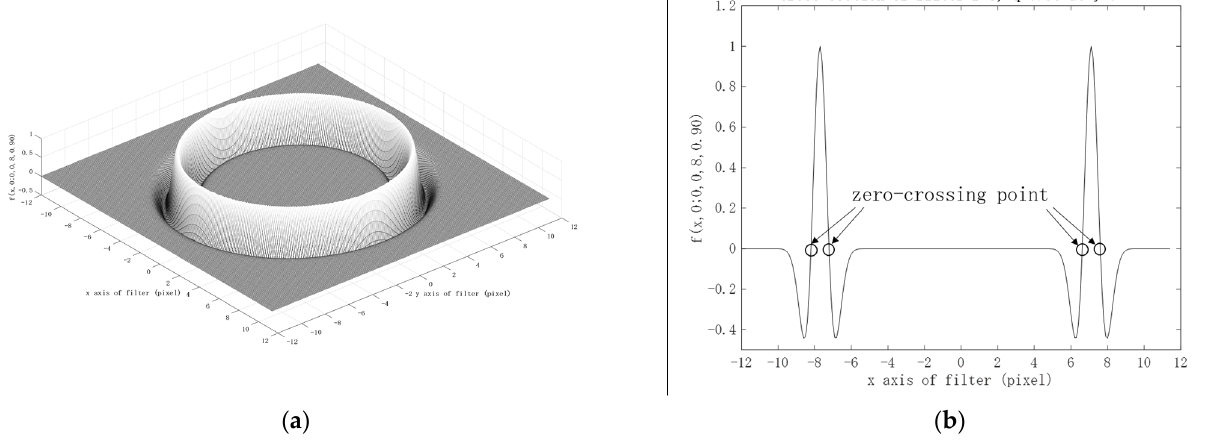
== yx , 8 = r , and 90.0 = q : ( a ) Bird’s-eye view; qryxyxf , with 0 Figure 4. The example of the function ),,,;,( Figure 4. The example of the function f ( x , y ; x 0 , y 0 , r , q ) , with x 0 = y 0 = 0, r = 8, and q = 0.90: ( a ) Bird’s-eye view; and 00 00 and ( b ) cross-section at y = 0. ( b ) cross-section at y =